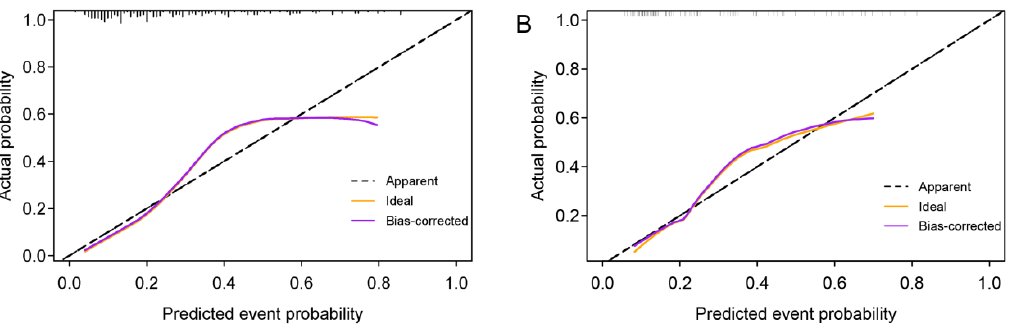
Figure 11. Calibration curves of the nomogram model in the training ( A ) and validation sets ( B ). Decision curve analysis of the clinical, Rad-score and nomogram models is shown in Figure 12. The gray line represents the assumption that all lesions were HER2+ type. The black line represents the assumption that all lesions were HER2 − type. If the threshold probability was less than 56.9%, using the nomogram would add more benefit (red line).